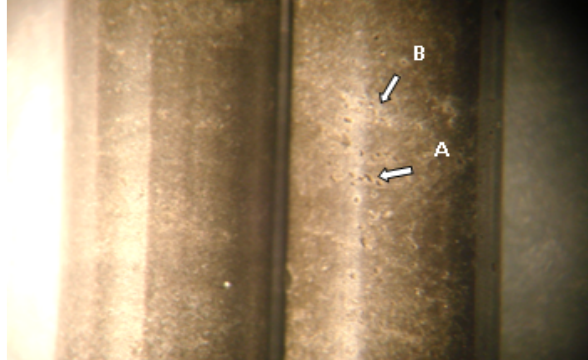
Figure 2 : Samples of set cement placed side by side u n-­‐